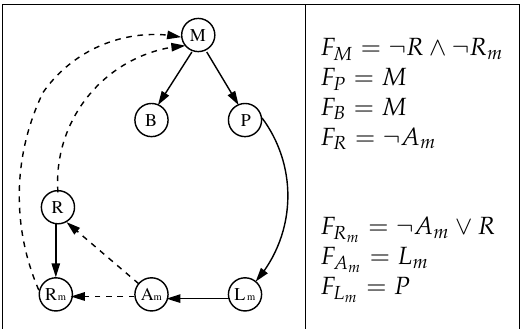
Figure 7. Digraph obtained when considering the parameters of case 4 ( left ) of Section 3.2 and its local functions after considering G e = L e = L = A = 0 and L em = C = 1 ( right